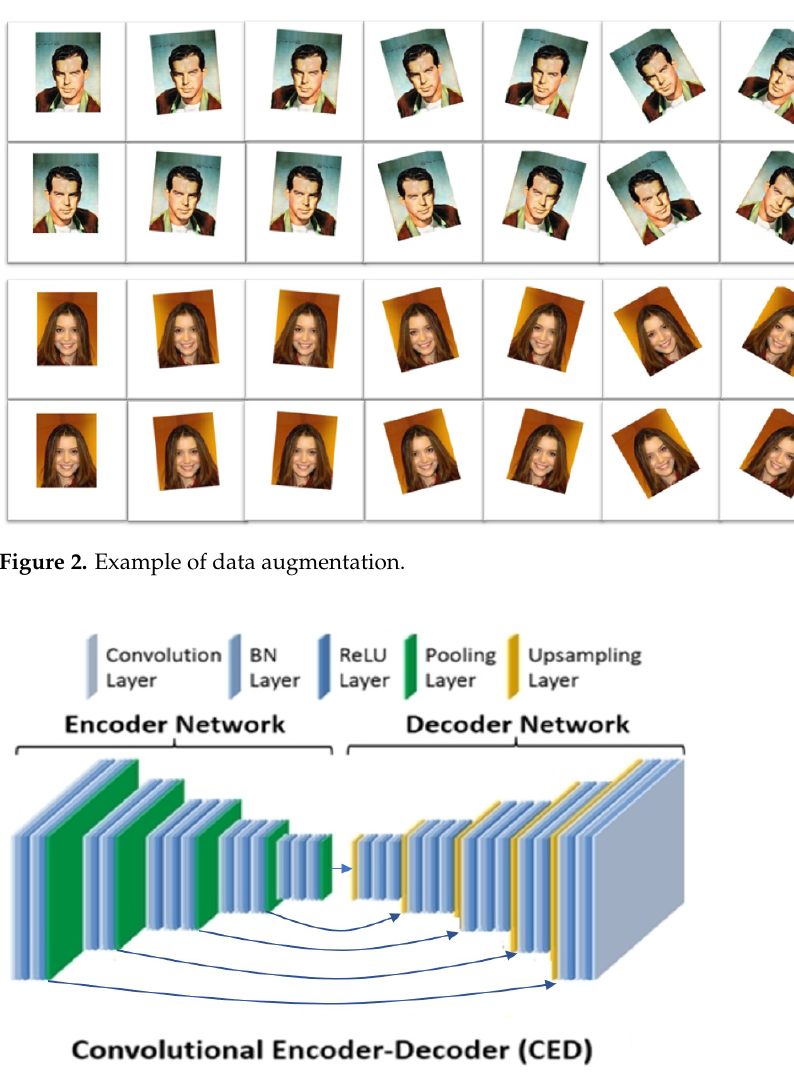
Figure 3. The basic structure of the encoder–decoder.